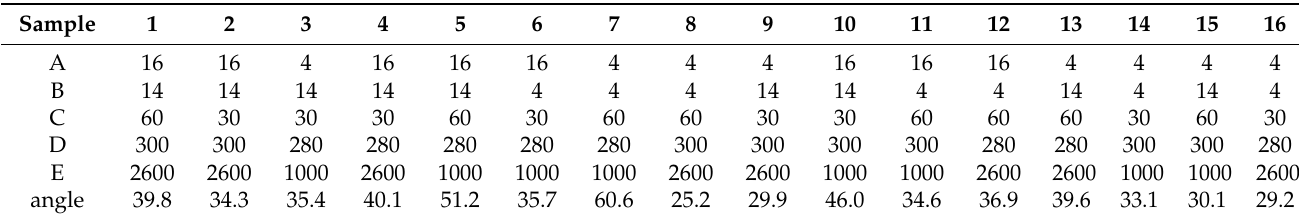
Table 2. Sample configuration with varying process parameters of plasma treatment A–E (cf. Table 1) and resulting contact